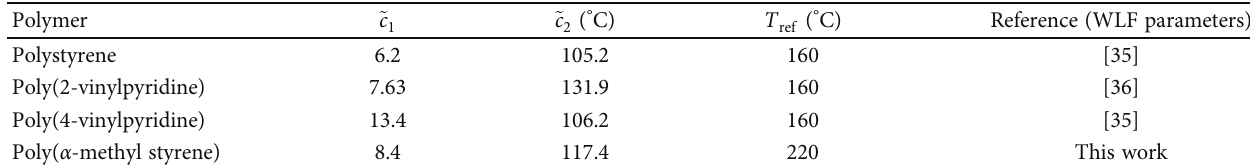
is (a) 160 ° C ref (cf. remark below Equation (4)). ref